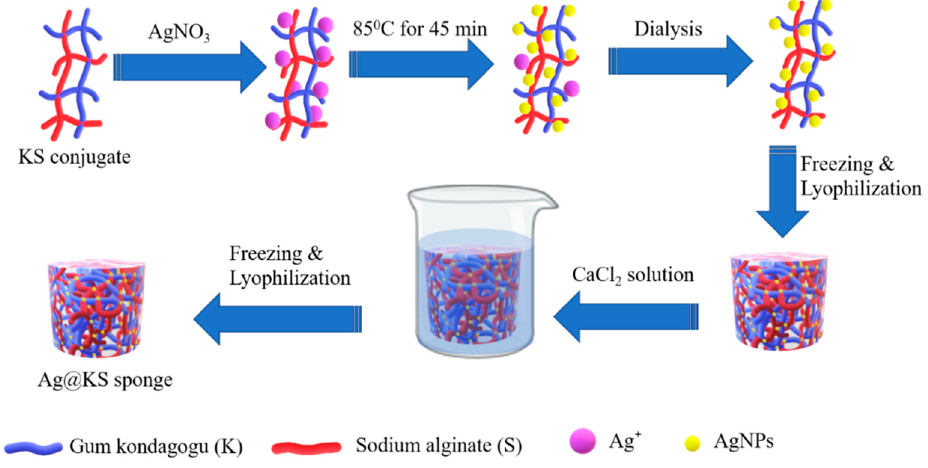
Figure 1. Schematic illustration of the Ag@KS sponge